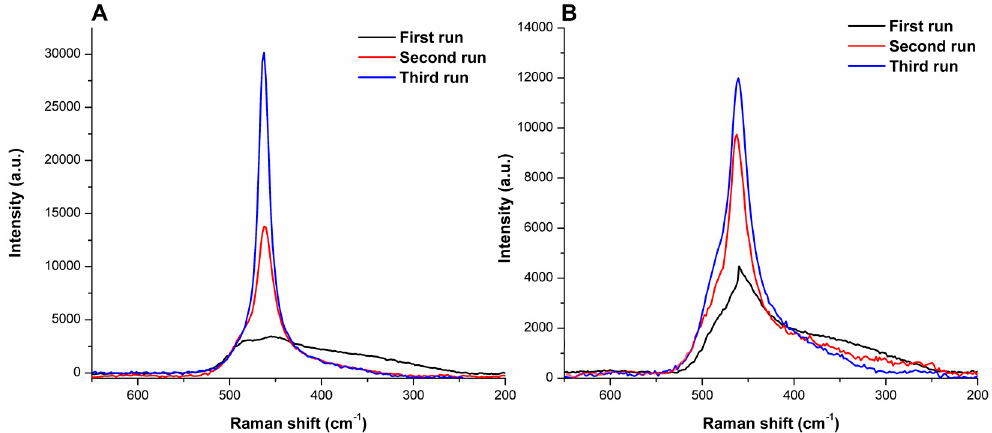
Figure 16. Raman spectra of recovered solids: Ce-MCM-Cl ( A ) and Ce-MCM-NO 3 ( B ).